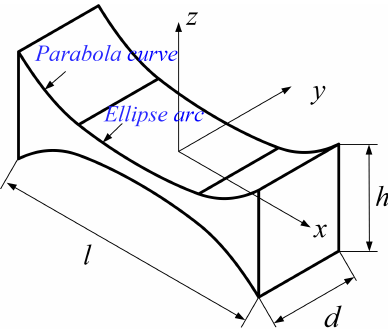
Figure 1. The 3-D model of the proposed ellipse-parabola shaped flexure hinge.